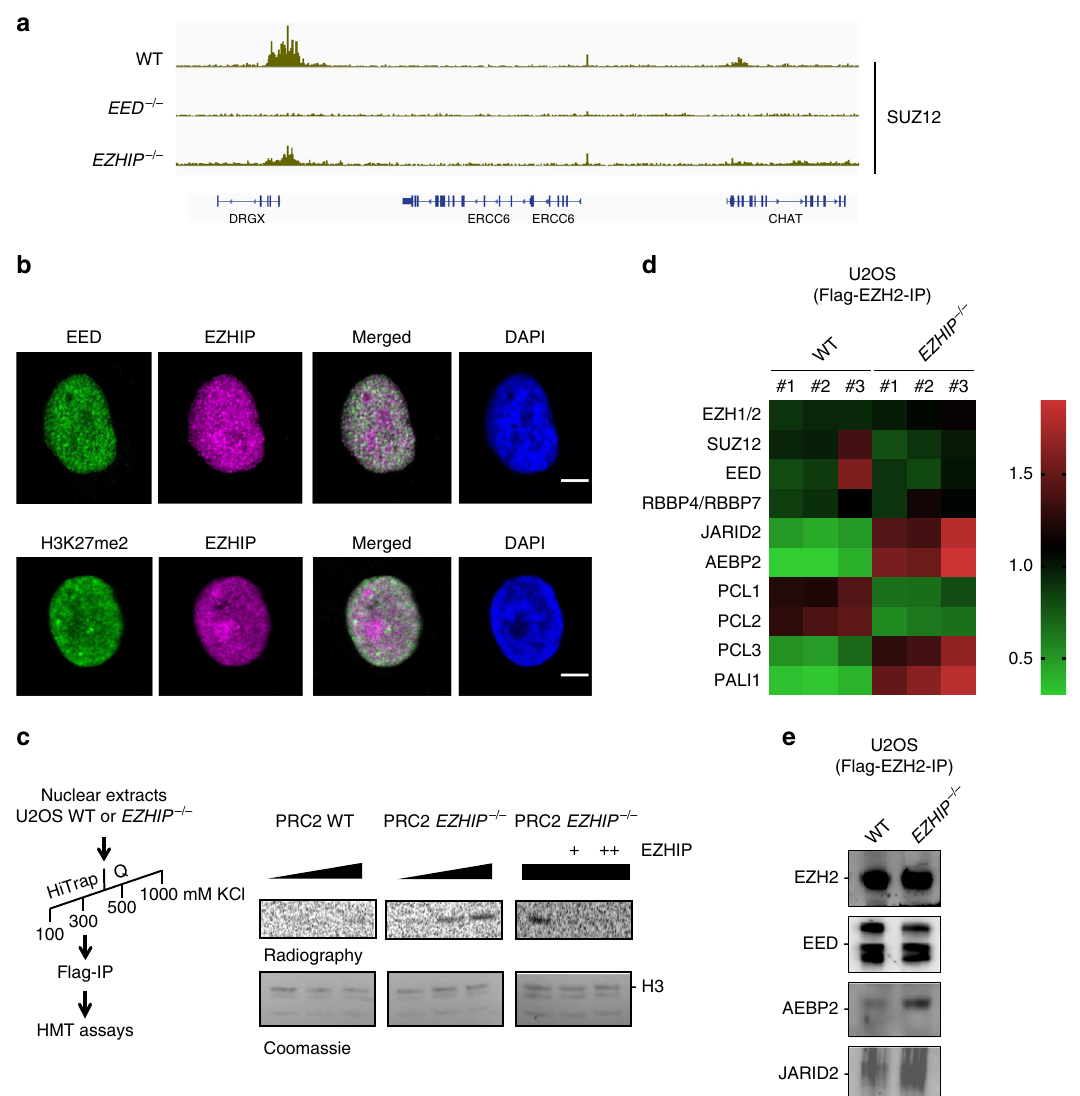
Fig. 4 EZHIP mitigates PRC2-cofactors interactions. a Genome-browser representation of SUZ12 enrichment in U2OS WT, EED − / − , and EZHIP − / − . Duplicates are merged, same scale for all tracks. b Immuno fl uorescence staining of EED and EZHIP (top) or H3K27me2 and EZHIP (bottom) on U2OS, nuclei are stained with DAPI. Representative results. Scale bar, 2 μ m. c Left, puri fi cation scheme for PRC2. Right, histone methyltransferase (HMT) assay to monitor the enzymatic activity of PRC2 puri fi ed from WT (left panel) or EZHIP − / − (middle panel) U2OS cells (titration: 1, 2, 5 × ) on native nucleosomes. Right panel, same assay as previously, but this time titrating recombinant hEZHIP on PRC2-puri fi ed from EZHIP − / − U2OS cells (PRC2 quantity 5 × ). The upper panels are autoradiography, and the lower panels are the corresponding SDS-PAGE coomassie staining. Representative image. d Quanti fi cation of EZH2-Flag IP through mass spectrometry (iBAQ values). Heatmap representing the Log2-transformed median centered values. Horizontal axis: U2OS WT and EZHIP − / − , n = 3. Vertical axes: PRC2 components. Values are normalized on iBAQ values from untagged U2OS WT and EZHIP − / − . e EZH2-Flag Co-IP from nuclear extracts either WT or EZHIP − / − , and probed with antibodies against EZH2, EED, AEBP2, or